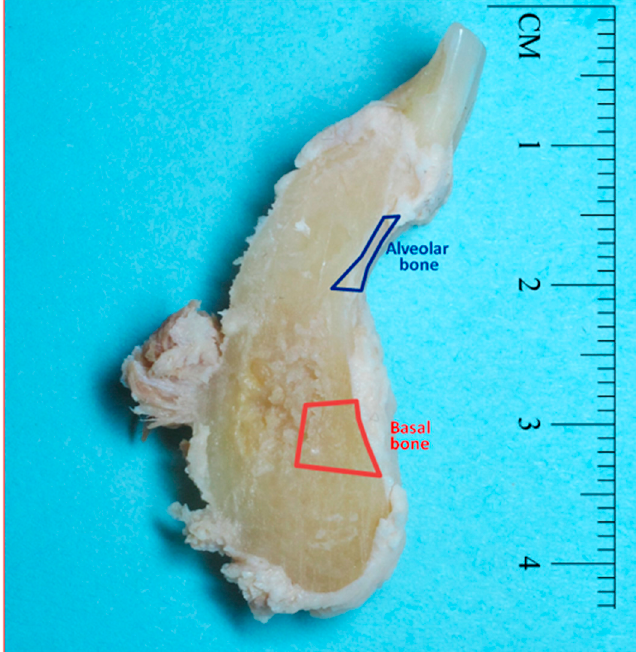
Figure 1. Image showing a representative human mandible jaw section after gross dissection where alveolar bone (blue outline) and basal bone (red outline) samples were harvested to be analyzed for cadmium (Cd) content.